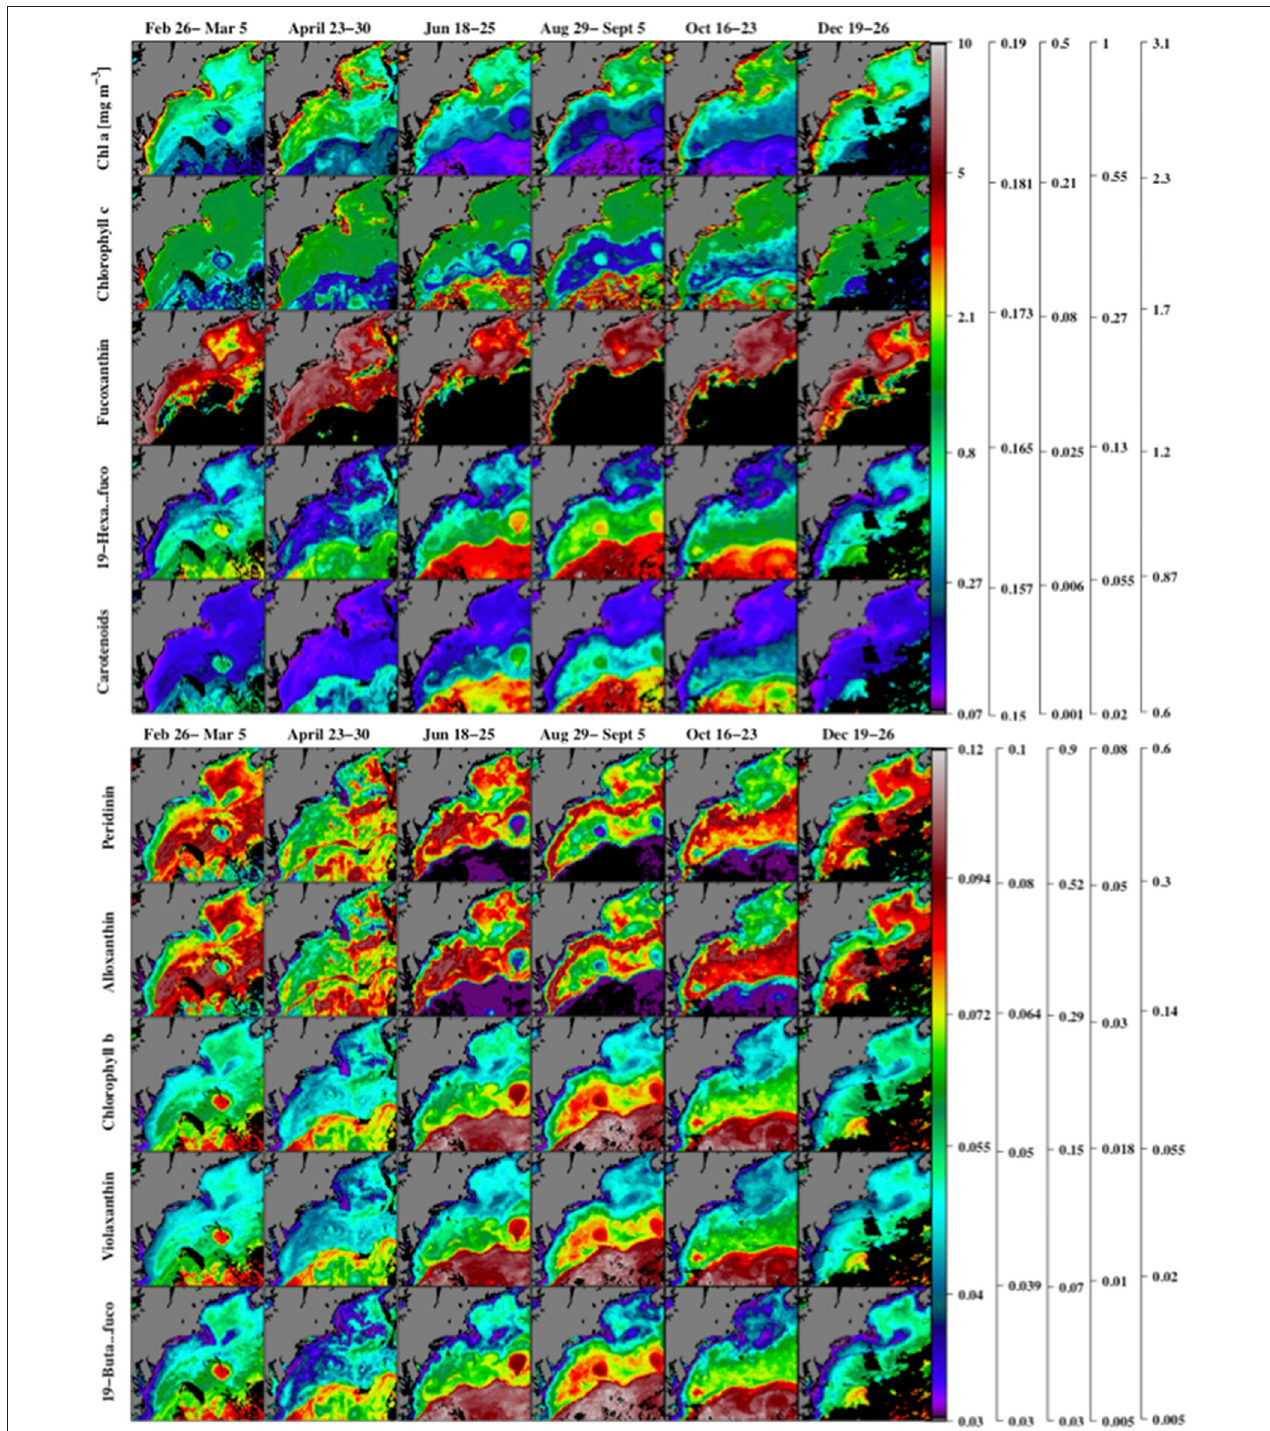
FIGURE 8 | Maps of the satellite-based inversion model estimates of chlorophyll a, Chl MOD SAT and the ratios of chlorophyll c, fucoxanthin, 19 ′ hexanoyloxyfucoxanthin, carotenoids ( α -carotene, B-carotene, diatoxanthin, diadinoxanthin, alloxanthin, zeaxanthin, lutein, fucoxanthin, peridinin, violoxanthin, 19 ′ butanoyloxyfucoxanthin, and 19 ′ hexanoyloxyfucoxanthin) to Chl MOD SAT (upper panel) using MODIS Aqua 2007 chlorophyll a observations. Similar ratios of peridinin, alloxanthin, chlorophyll b, violaxanthin, and 19 ′ butanoyloxyfucoxanthin to Chl MOD SAT are shown in the lower panel. Note that the nonlinear colored scale bars differ for each pigment, and the scales from left to right are associated with the pigments from top to bottom. Regions where the inverse model yielded zero concentrations are shown in black.